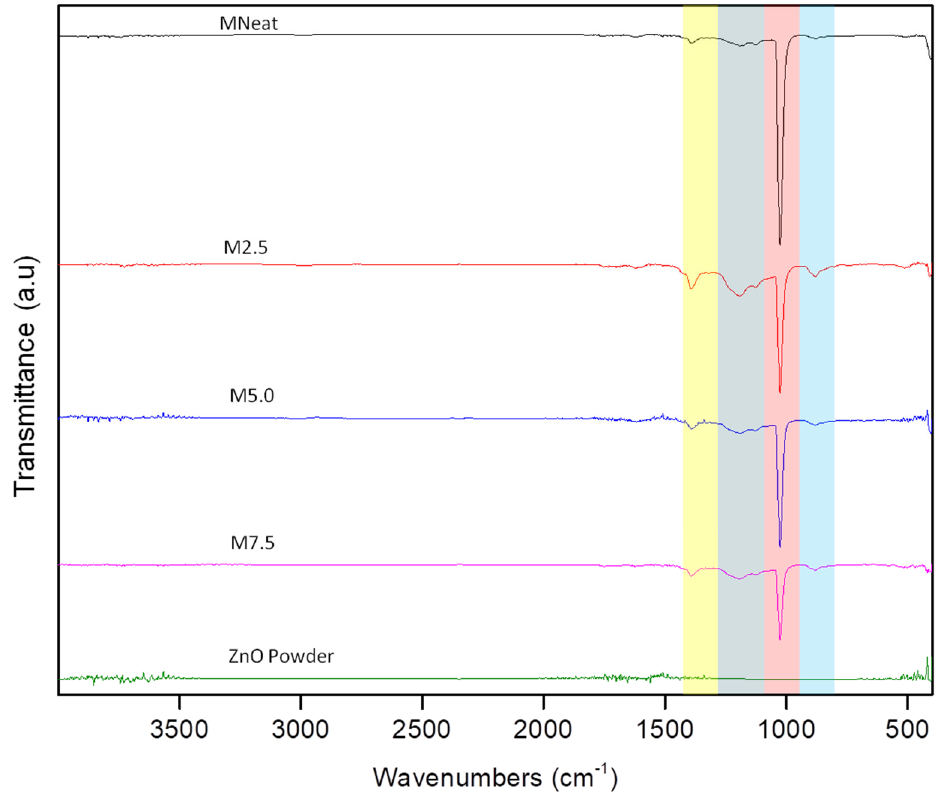
Figure 5. FTIR spectra of MNeat, M.25, M5.0, and M7.5 hollow fiber membranes .